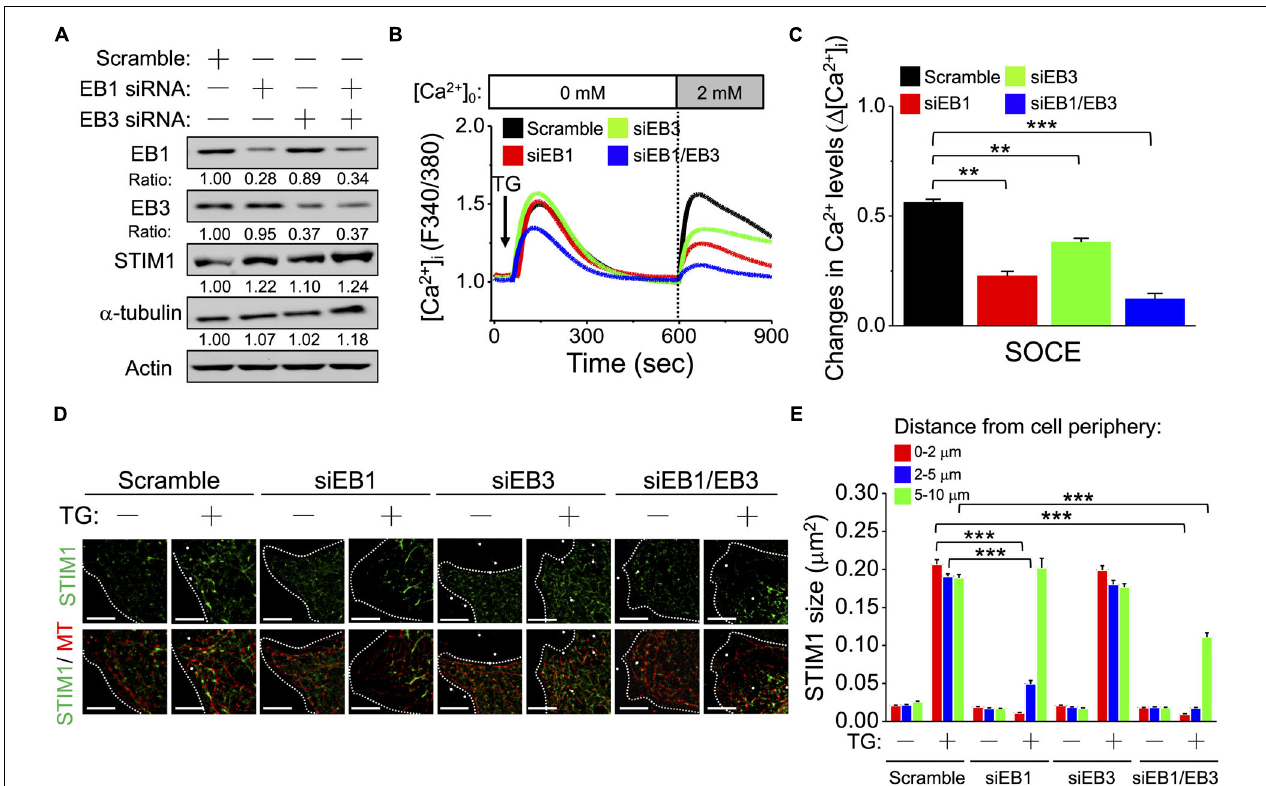
FIGURE 5 | Microtubules plus end-binding proteins play important roles in regulating STIM1 trafficking. (A) EB1 and EB3 were silenced by siRNA. Representative immunoblots showing the expression levels of EB1, EB3, STIM1 and α -tubulin in SiHa cells. Expression of EB1, EB3, STIM1 and α -tubulin was normalized against β -actin. (B) The representative recordings from three different experiments to show [Ca 2 + ] i induced by 2 µ M TG in extracellular Ca 2 + ([Ca 2 + ] o )-free media followed by replenishment of [Ca 2 + ] o . The SOCE amplitude indicates the rise of [Ca 2 + ] i in replenishment of [Ca 2 + ] o from 0 to 2 mmol/L. Arrow, adding 2 µ M TG. (C) Quantitative analyses of changes in Ca 2 + levels ( (cid:49) [Ca 2 + ] i ). Column, mean ± SEM from three independent experiments, each independent experiment concluding at least 30 cells. ** P < 0.01, *** P < 0.001, compared with control group by one-way ANOVA with a Dunnett’s post hoc test. (D) Representative images of cervical SiHa cancer cells overexpressing EGFP-STIM1 after EB1- or EB3-silencing for 72 h. Dashed line, cell periphery. White dots, TetraSpeck microspheres. Scale bar, 5 µ m. (E) The molecular size of STIM1 by dSTORM imaging was analyzed based on their distance from cell periphery. Column, mean ± SEM from at least five different cells of three independent experiments. *** P < 0.001, compared with control group by one-way ANOVA with a Dunnett’s post hoc test.